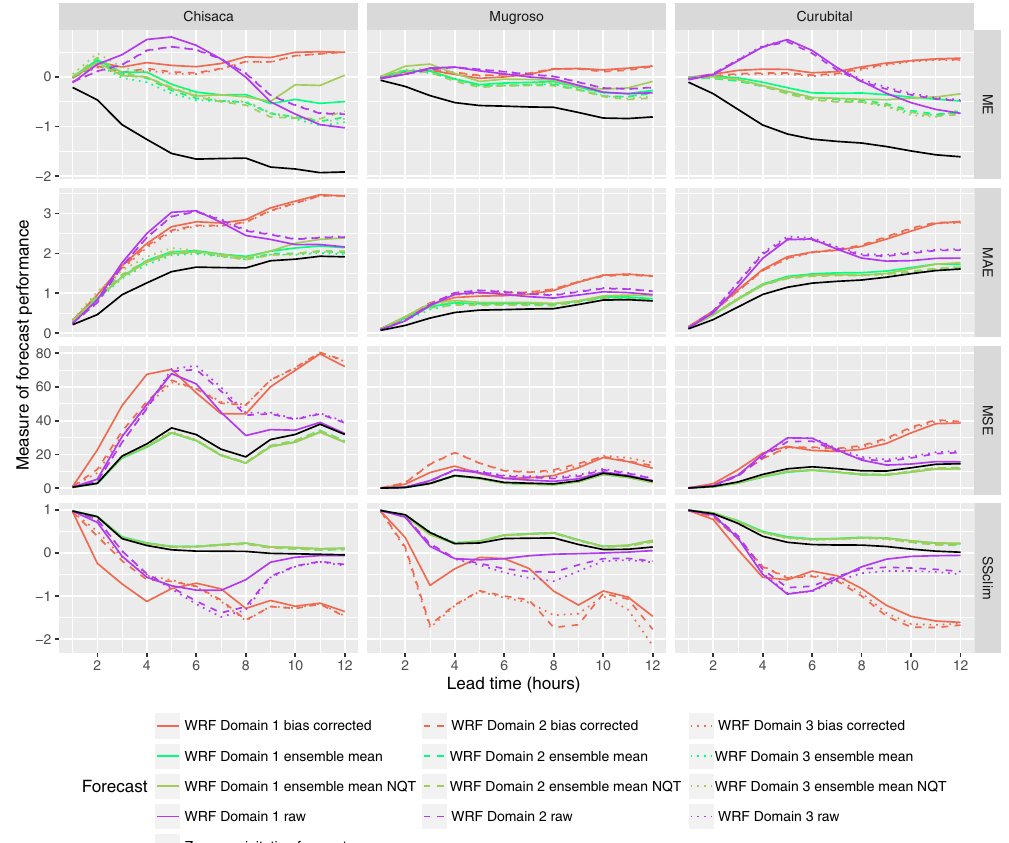
Figure 7. Performance measures for deterministic discharge and ensemble mean forecasts. Domain 1, domain 2 and domain 3 correspond respectively to the domains with resolutions 15, 5 and